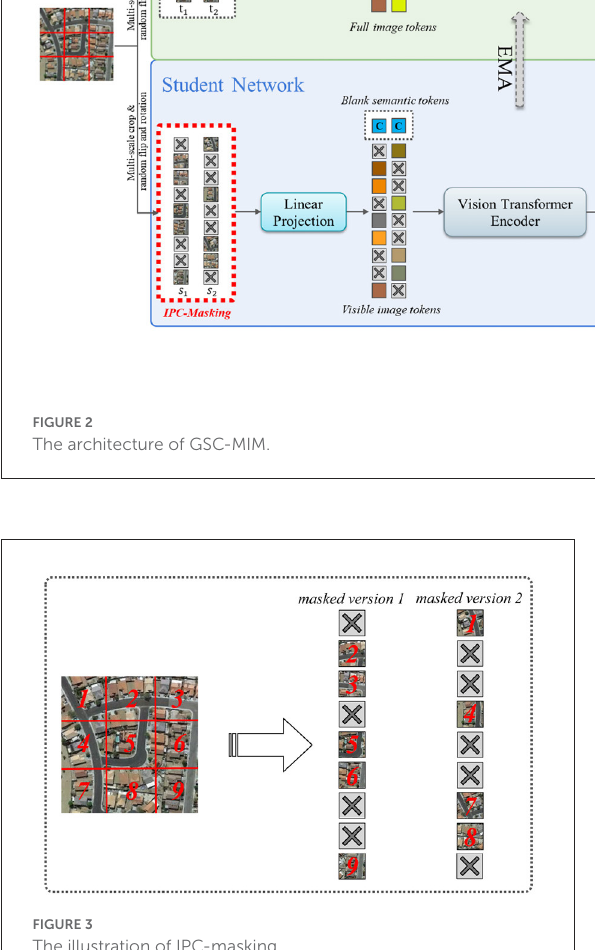
FIGURE3 The illustration of